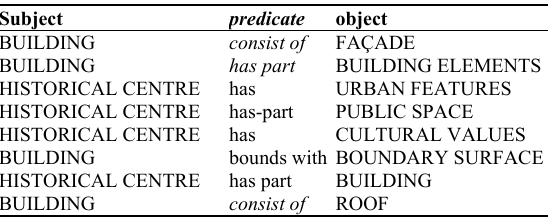
Table 3. Triples of concept implemented during the ontology enrichment.